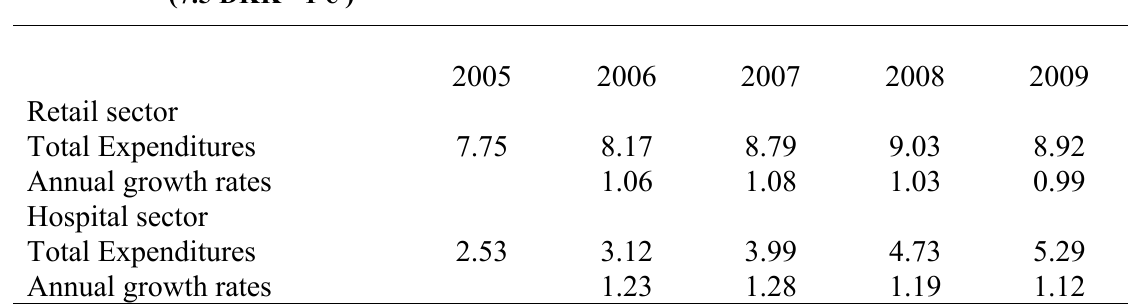
Annual expenditures and expenditure growth rates in the pharmaceutical retail and hospital sector in billions of Danish kroner (7.5 DKK =1 € )